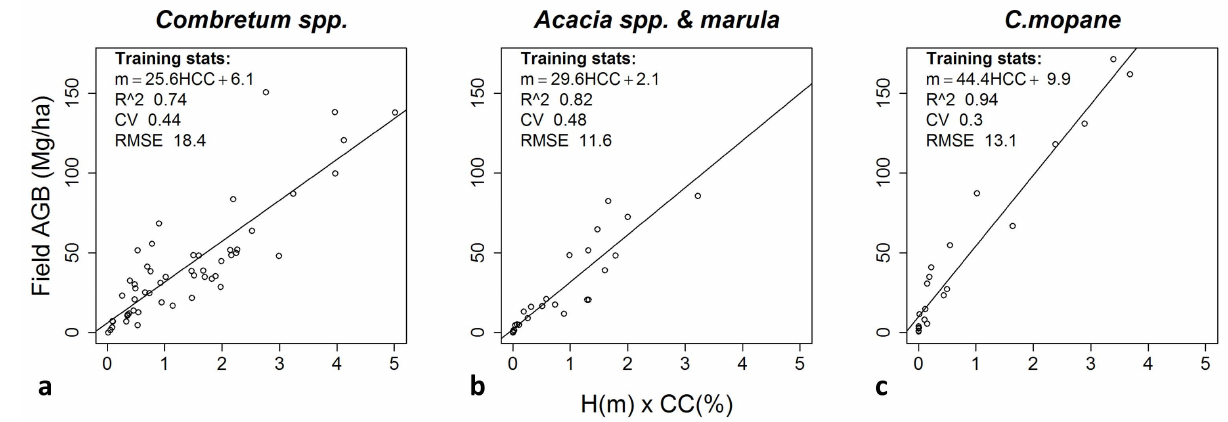
Fig. 2. Model calibration to predict AGB using airborne LiDAR. Points represent calibration field plots. Three models were trained accor- ding to dominant woody species: (a) mixed broadleaf ( Combretum apiculatum, Combretum collinum) and fineleaf ( Acacia nigrescens, Dichrostachys cinerea) savanna, (b) Acacia spp. and marula ( Sclerocarya birrea) savanna, and (c) mopane ( Colophospermum mopane )